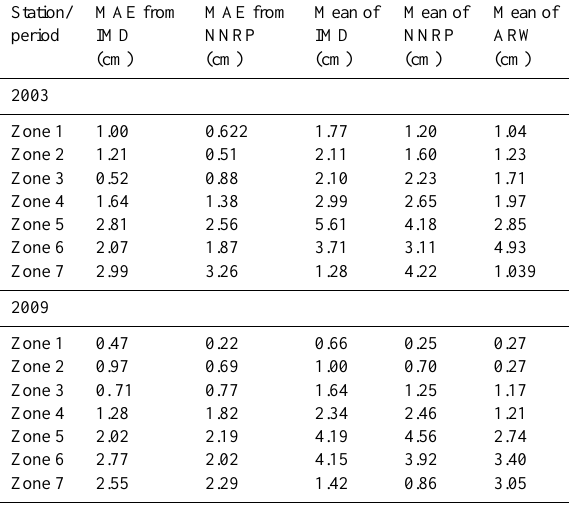
Table 4. Mean absolute error (MAE) between pentad rainfall time series based on ARW simulation, NNRP precipitation and IMD ob- served rainfall from 16 May to 15 July for the years 2003 and 2009 for different zones.